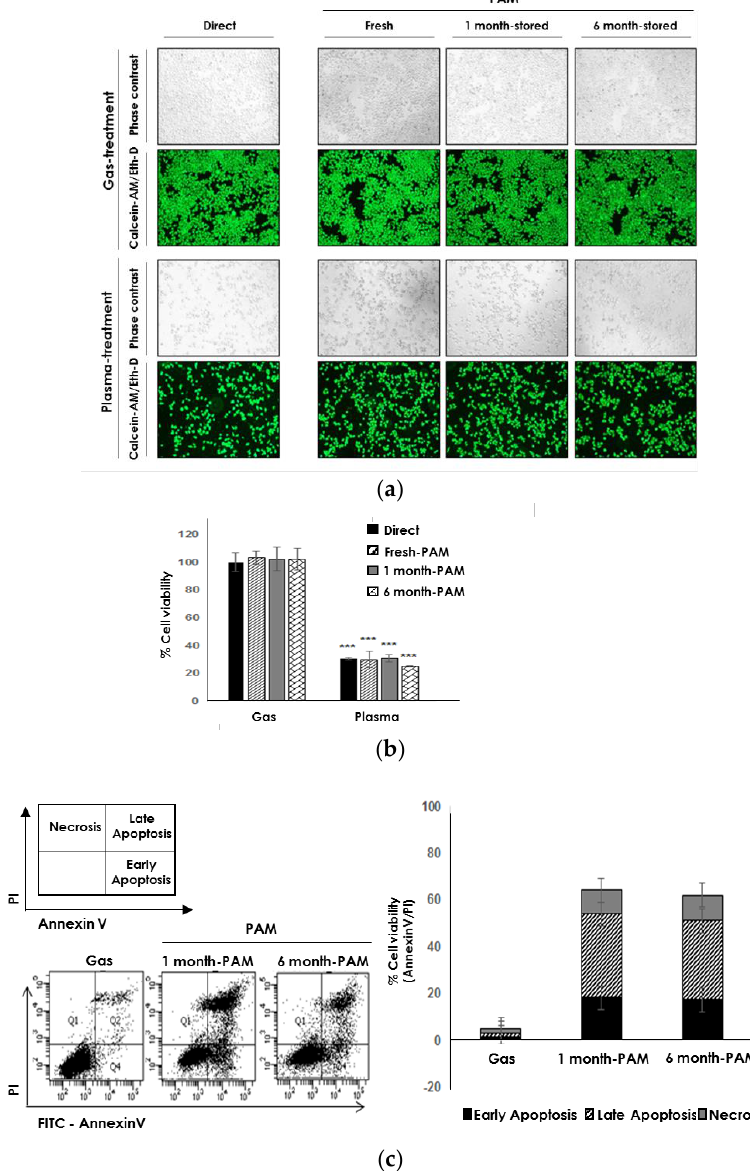
Figure 5. Efficacy of frozen PAM. PAM was stored in a freezer ( − 20 ◦ C) for the indicated periods (1 and 6 months), then thawed and added to HeLa cells to evaluate its efficacy. ( a ) Human cervical HeLa cancer cells were treated with plasma (direct plasma or fresh and 1- or 6-month stock PAM) (plasma-treatment) or gas (gas or gas-treated fresh and stock medium) (gas-treatment) for 24 h. Cellular viability was assessed using calcein-AM and EthD-1 to detect live and dead cells, respectively. ( b ) Cell viability was measured by MTT assay and compared to those of gas-treated control cells. ( c ) Cell death via apoptosis/necrosis was detected by staining the cells with FITC-conjugated annexin V and propidium iodide (PI), respectively, and by flow cytometric analysis, and compared to that in gas-treated cells. The dot plots show representative images of apoptotic cell death after PAM-treatment, identified by labeling phosphatidylserine on the membrane surface of early/late apoptotic cells with annexin V, and by labeling DNA of late apoptotic/necrotic cells with PI. The graph shows the populations of apoptosis/necrotic cells.